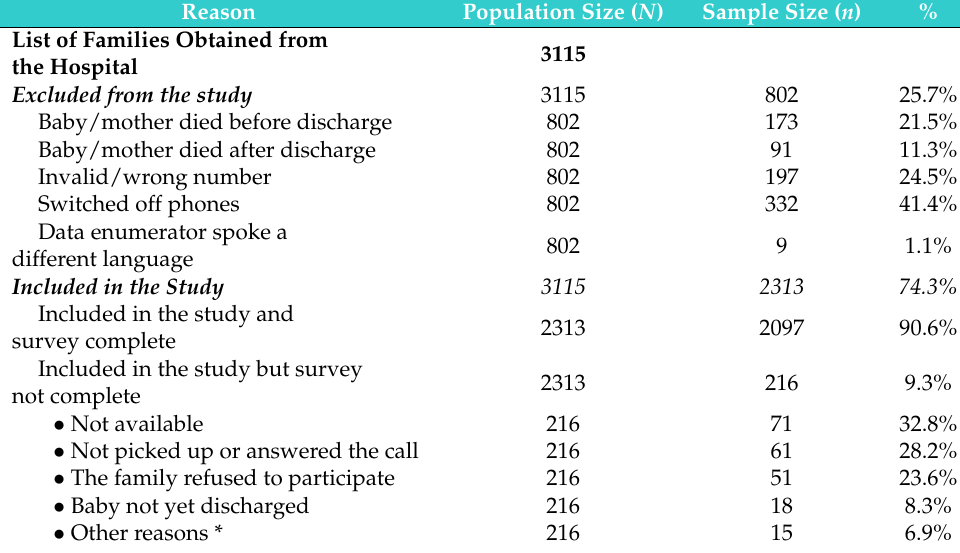
Table 1. Selection criteria for study